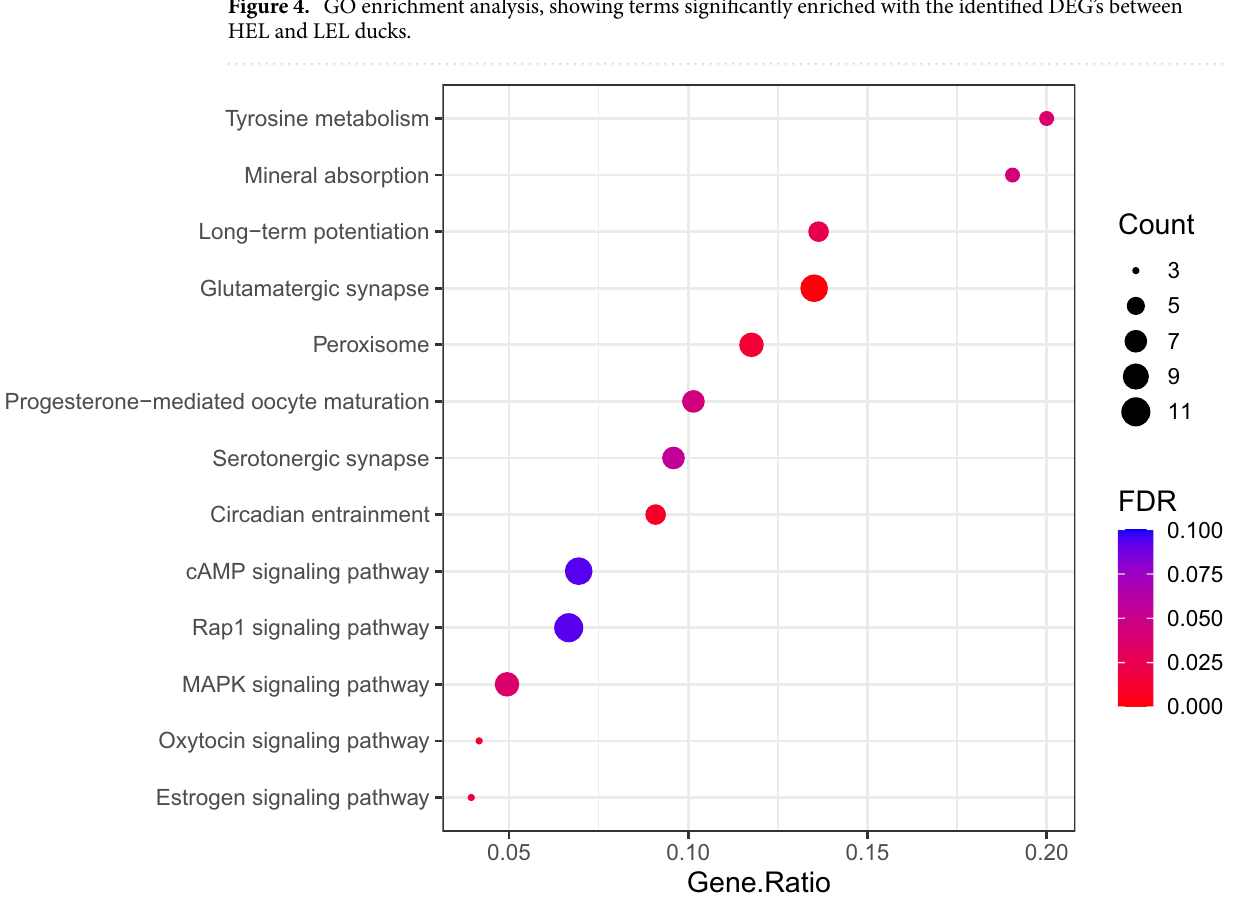
Figure 5. KEGG pathways enriched by the DEGs. The x axis represents the GeneRatio of the enriched genes and y axis shows the names of the enriched pathways. The area of each dot represents the number of enriched genes and the color represents the significance of the FDR value (red represents high significance, while blue represents